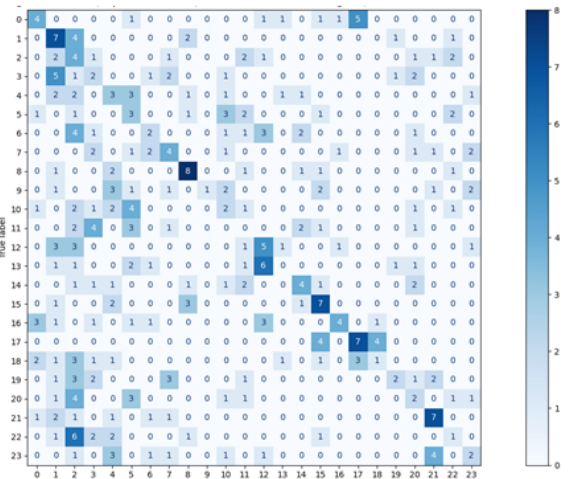
Figure 3. Confusion Matrix— k NN, k = 5.